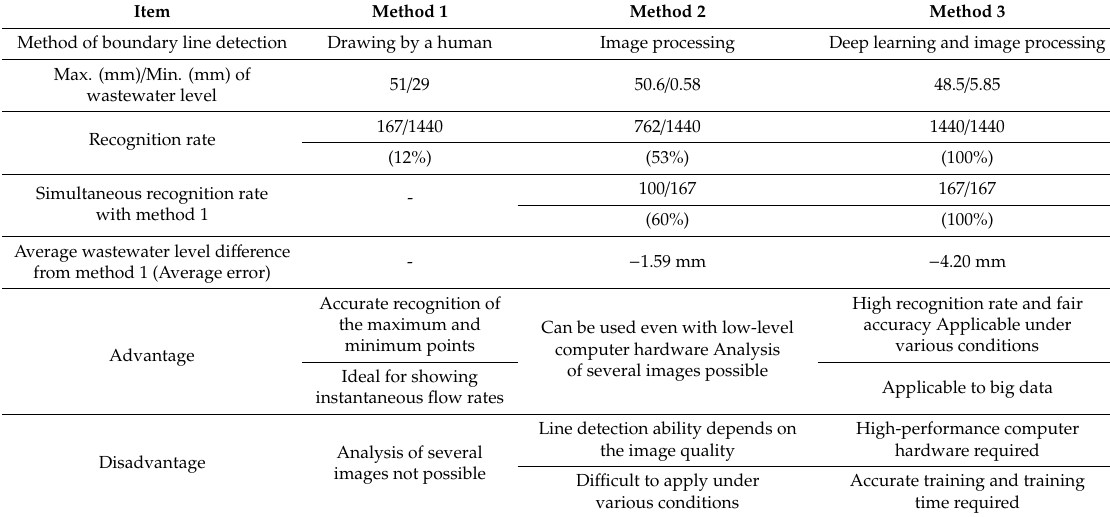
Table 1. Comparison between wastewater levels determined using di ff erent methods for wastewater boundary line